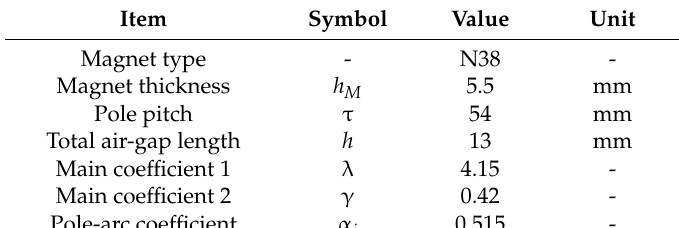
Table 4. The prototype parameters.